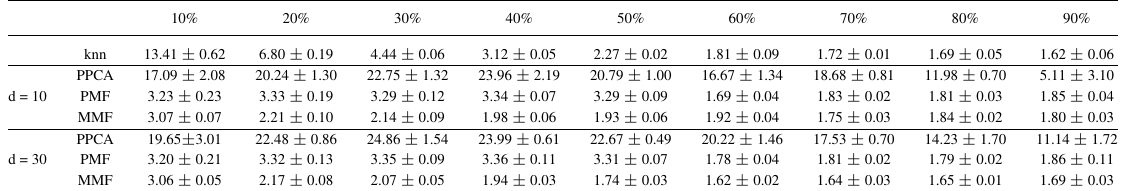
Table 1. Recovery errors on the synthetic dataset (mean ±